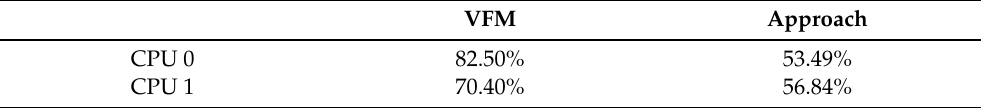
Table 9. Processor usage